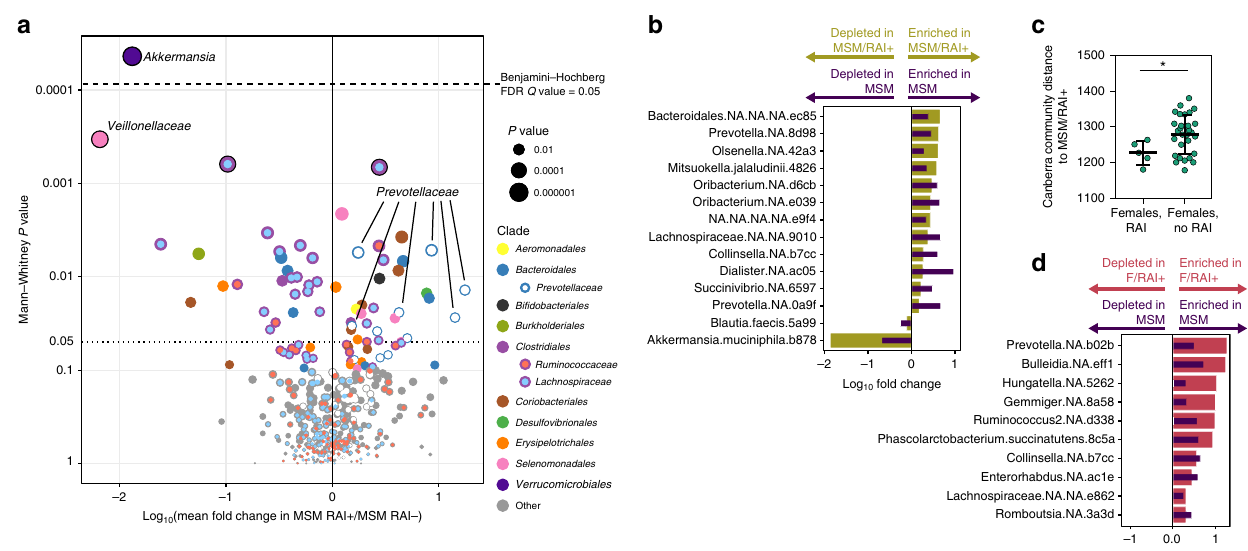
Fig. 4 Recent sexual practice and lifetime sexual practice impacts gut microbiota composition regardless of sex. a Volcano plot depicting ASVs in differential abundance between MSM/RAI + (men who have sex with men that experienced receptive anal intercourse within the last 6 months prior to sampling, n = 44) and MSM/RAI − (men who have sex with men that did not experience receptive anal intercourse within the last 6 months prior to sampling, n = 28), matched for infection status. b Overlap in abundance trends among the top 100 taxa in differential fold abundance among MSM vs. MSW ( n = 72 MSM, n = 22 MSW) and MSM/RAI + vs. MSM/RAI − ( n = 44 MSM/RAI + , n = 28 MSM/RAI − ). Mann – Whitney tests were performed on each ASV for both comparisons, and shown are taxa that reached P < 0.05 on both lists. c Average Canberra community distances to MSM/RAI + were calculated for each female participant sample that reported receptive anal intercourse within 6 months prior to sampling (F/RAI + , n = 5) and female participants that reported no such activity (F/RAI − , n = 28). F/RAI + gut communities were signi fi cantly more similar to MSM/RAI + than were those for F/RAI − . Unpaired two-tailed t -test P = 0.0496. Middle bar denotes average and error bars represent SD. d Overlap in abundance trends among the taxa that reached P < 0.05 in both comparisons of MSM vs. MSW and F/RAI + vs. F/RAI − (Fisher ’ s exact test P = 0.077), as performed in b